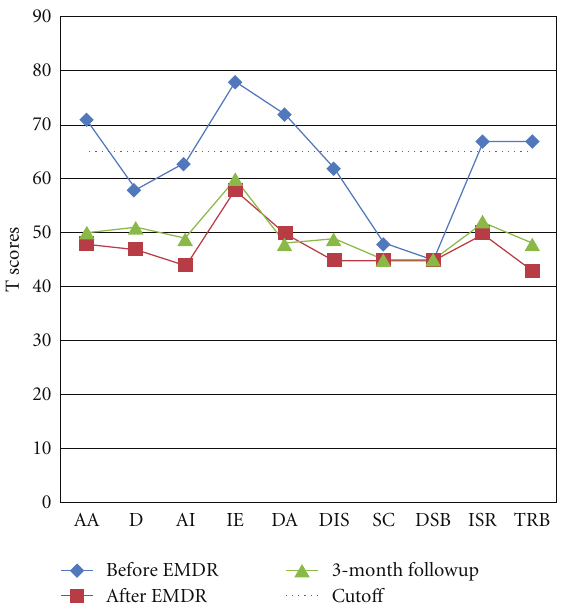
Figure 1: Results of Trauma Symptom Inventory [13] in pre- treatment, posttreatment, and three-month followup. Note : (1) Trauma Symptom Inventory subscales include anxious arousal (AA), depression (D), anger/irritability (AI), intrusive experience (IE), defensive avoidance (DA), dissociation (DIS), sexual concern (SC), dysfunctional sexual behavior (DSB), impaired self-reference (ISR), and tension reduction behavior (TRB). (2) All symptom scores dropped below clinical level (i.e., T score less than 65) in posttreatment and 3-month followup.